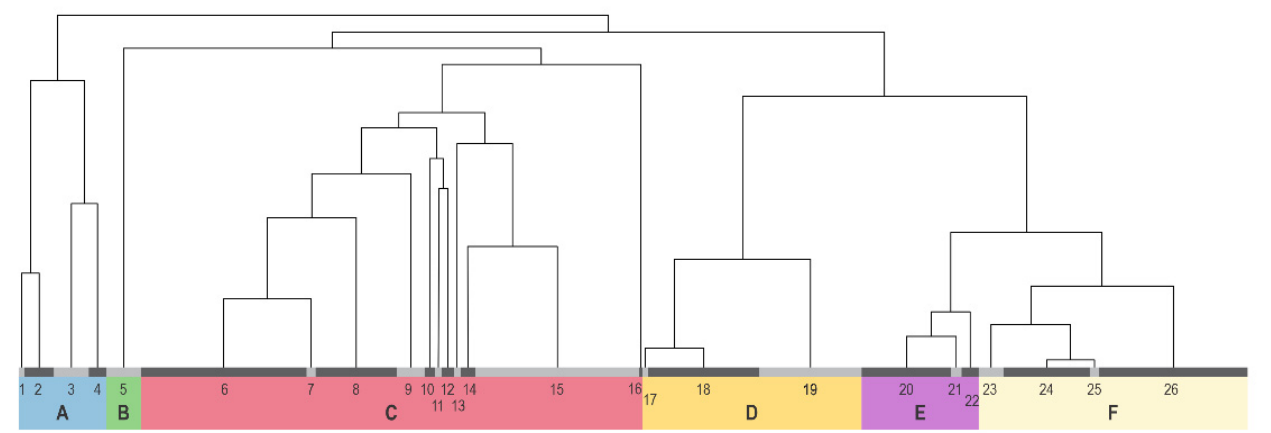
Figure 2. Dendrogram of ruderal vegetation relevés. Major vegetation groups are labeled with letters (A, B, C, D, E, F). Clusters are represented with numbers and correspond to cluster numbers in Table 1.